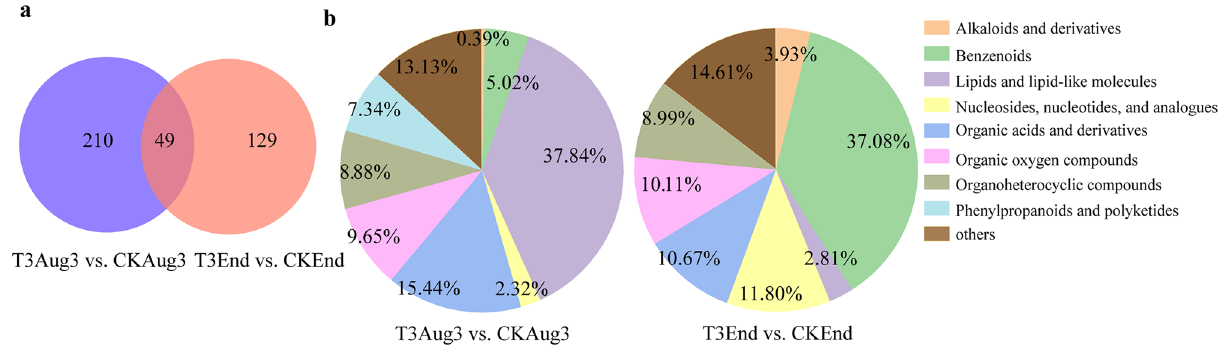
Figure 5. Statistical and analytical charts of differentially abundant metabolites (DAMs). ( a ) Venn diagram of DAMs in 2 comparison groups, ( b ) Pie chart of DAMs classification. T3Aug3 (samples from the T3 treatment on August 3rd), CKAug3 (samples from the CK treatment on August 3rd), T3End (samples from the T3 treatment on September 2nd) and CKEnd (samples from the CK treatment on September